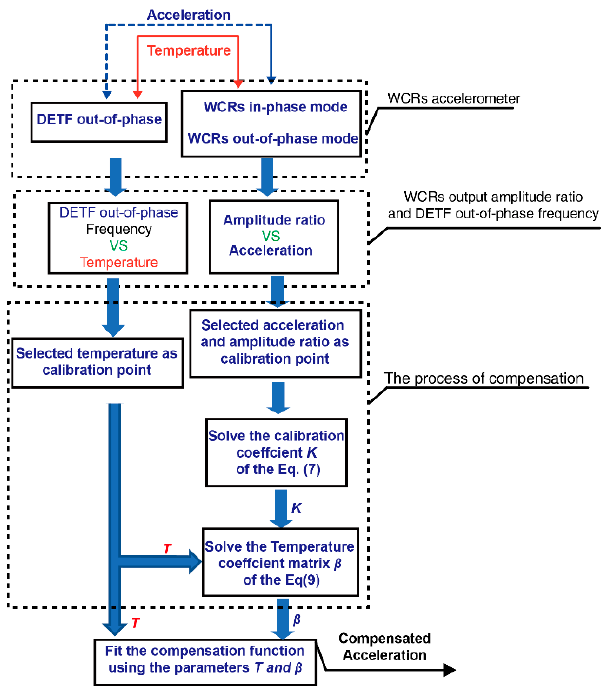
Figure 7. The flow charts implement the DETF-CC WCRs accelerometer temperature compensation method. tion